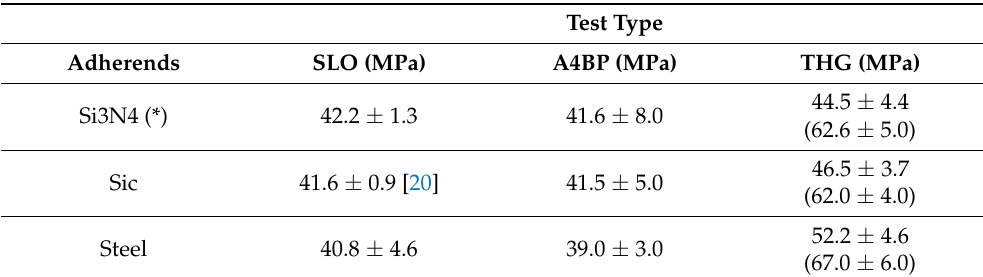
Table 1. Results after mechanical tests on Hysol EA9321 joined samples. Torsional (THG) shear strength results obtained by analytical modelling (in grey, in parentheses, are the results obtained by using the maximum of the torsion curve, for discussion purposes